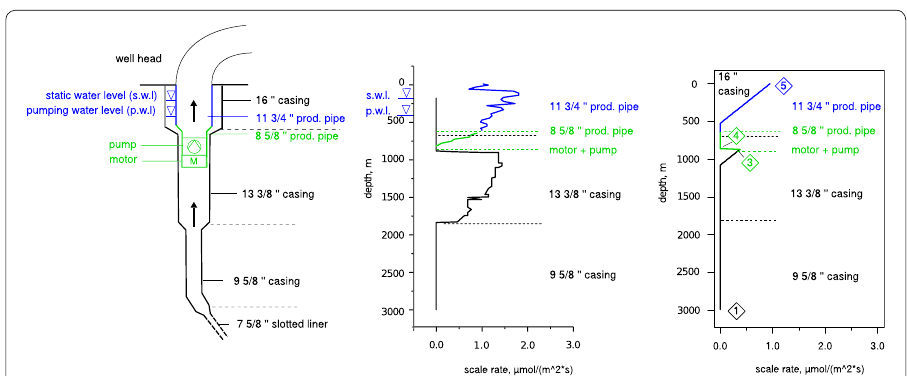
Fig. 9 Left: Schematic drawing of production side at site 6 (not to scale). Middle: Scale rate in the casing (black line) of that site calculated from MFC measurements in 2010 and 2015 with measurements available only below water level. The scale rate in the production pipe (blue and green line) was determined from three time periods. Right: Modeled scale rate based on the regression in Figure 4